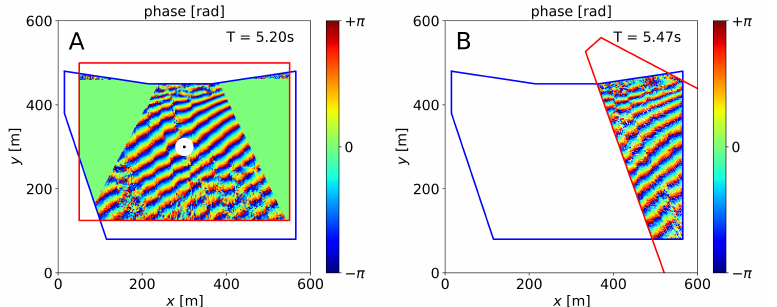
Figure 6. Spatial phase of two modes obtained for videos of planviews ( A ) and raw images ( B ). The white circle ( A ) represents the size of the neighborhood to estimate the